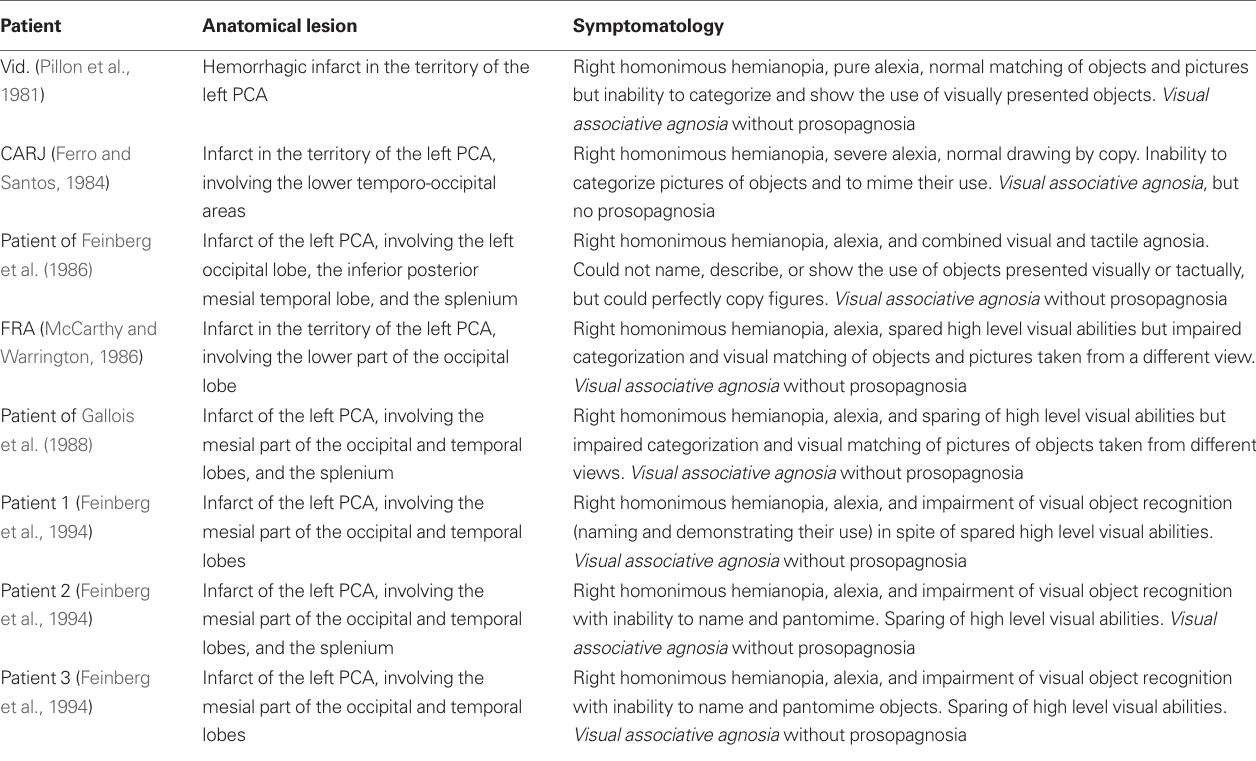
Three main observations can be made from the data presented in Table 2 : (1) First, a high proportion of the few left brain- damaged patients with a face recognition (or identification) defect reported in the literature were left-handed. This was the case for patients AC and DN, reported respectively by Tzavaras et al. (1973) and Mattson et al. (2000) and for patient 015 reported